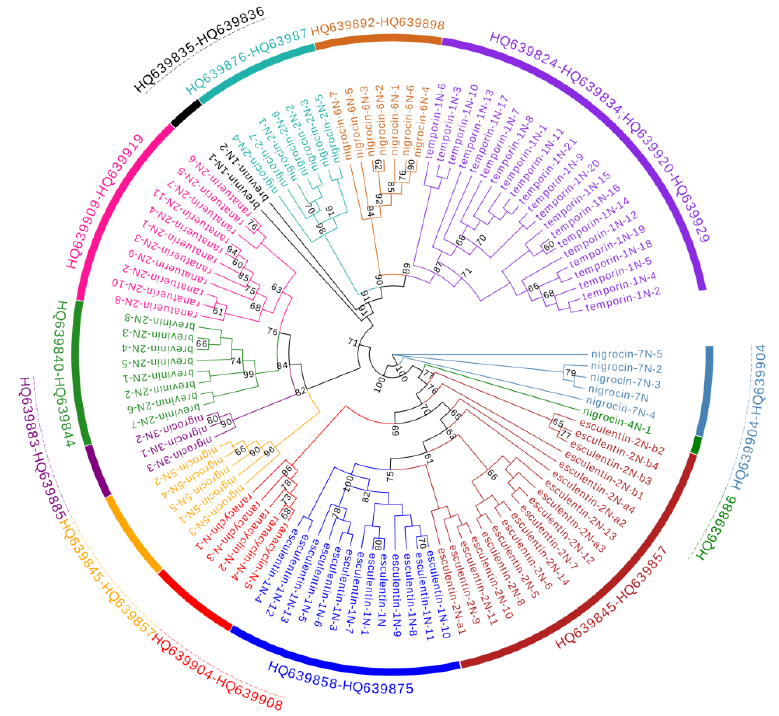
Figure 3. A phylogenetic tree of antimicrobial peptide (AMP)genes identified from P. nigromaculatus . Numbers in the figure are confidence values with bootstrap 1000 replicates; only values ≥ 60 are shown.